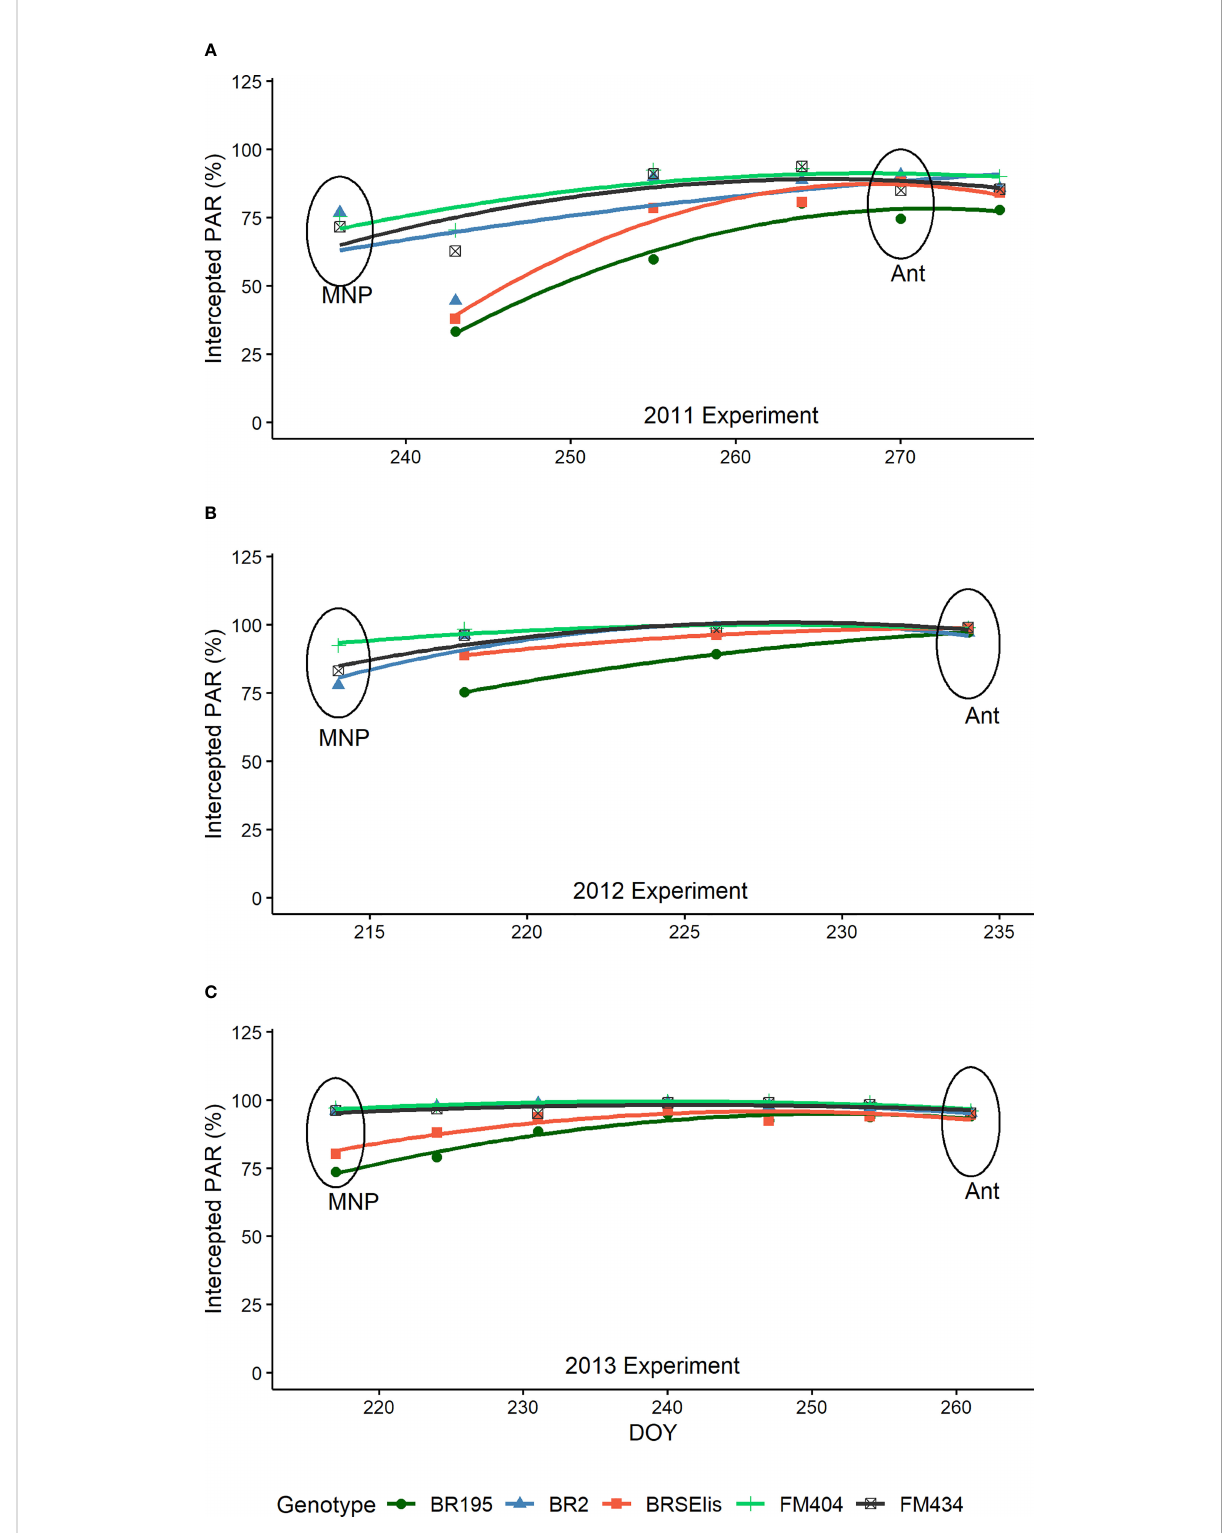
FIGURE 4 Photosynthetically active radiation (PAR) intercepted by barley cultivars released in different decades in Brazil in 2011, 2012, and 2013 experiments (A – C) . The circles indicate the position of the phenological stages evaluated. MNP, Maximum number of spikelet primordia; Ant,